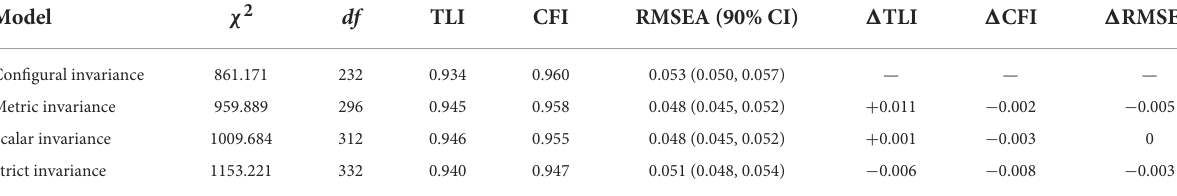
TABLE 5 Multi-group ESEM comparison nested model fitting index (gender invariance, N = 1,933).